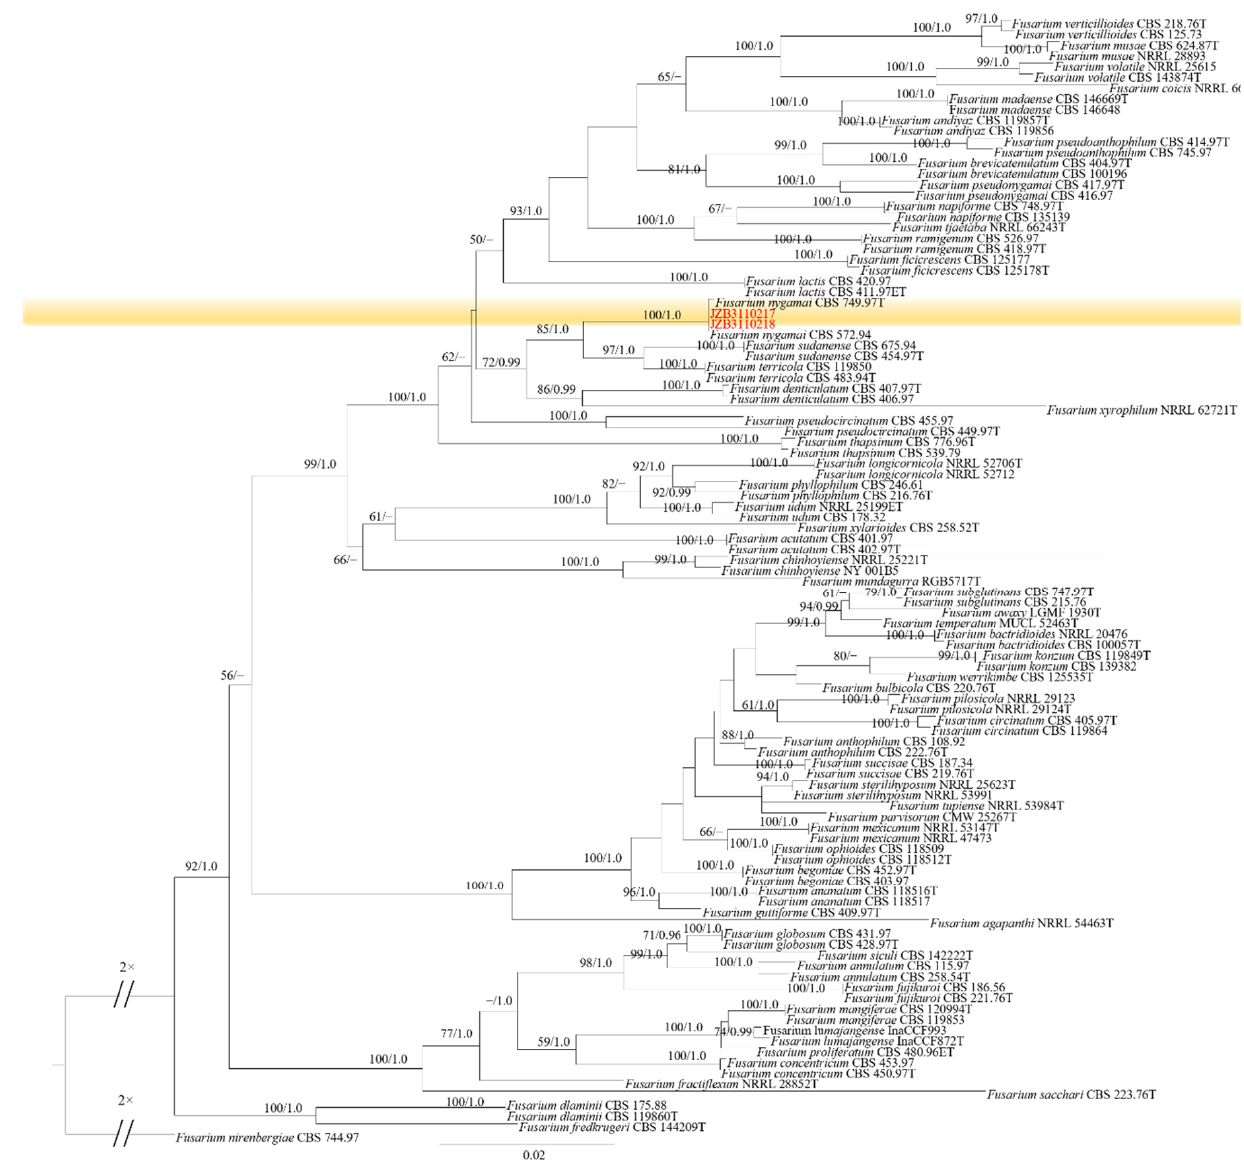
Figure 4. Phylogenetic tree generated by maximum likelihood analysis (RAxML) of FFSC based on the combined tef1 , rpb2 , tub2 and CaM sequence data. The tree is rooted with Fusarium nirenbergiae (CBS 744.97). The best-scoring RAxML tree with a final likelihood value of –16,169.804811 is presented. The matrix had 1172 distinct alignment patterns, with 12.61% of undetermined characters or gaps. Estimated base frequencies were as follows: A = 0.246851, C = 0.265429, G = 0.243377, T = 0.244344; substitution rates AC = 1.195289, AG = 4.703565, AT = 1.258970, CG = 0.717390, CT = 9.004544, GT = 1.000000; gamma distribution shape parameter α = 0.838651. ML bootstrap support values ≥ 50% and Bayesian posterior probabilities (BYPP) ≥ 0.95 are given near the nodes. The scale bar indicates 0.03 changes per site. Isolates belonging to this study are given in red.